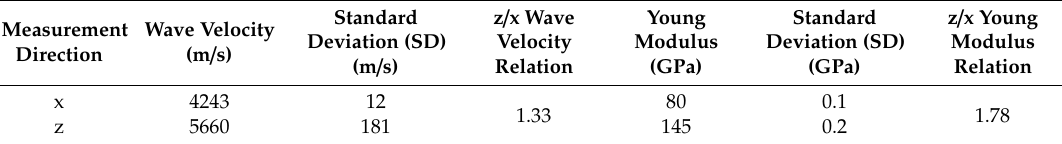
Table 1. Results of ultrasonic measurements for reference sample show texturing influence of hot pressing.